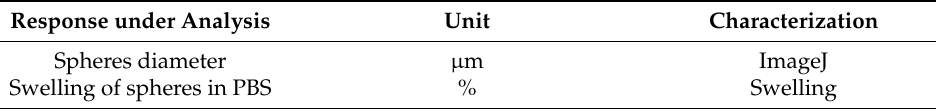
Table 3. Response variables of the factorial planning. Response under Analysis Unit